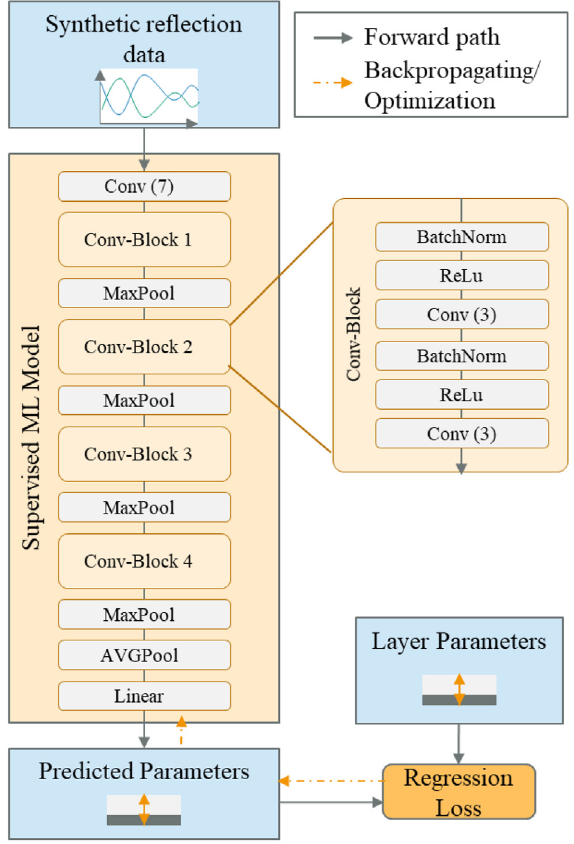
Fig. 2. Architecture and of the classic CNN Network. The arrows indicate the information fl ow during training, grey shows the forward propagation and orange the optimization